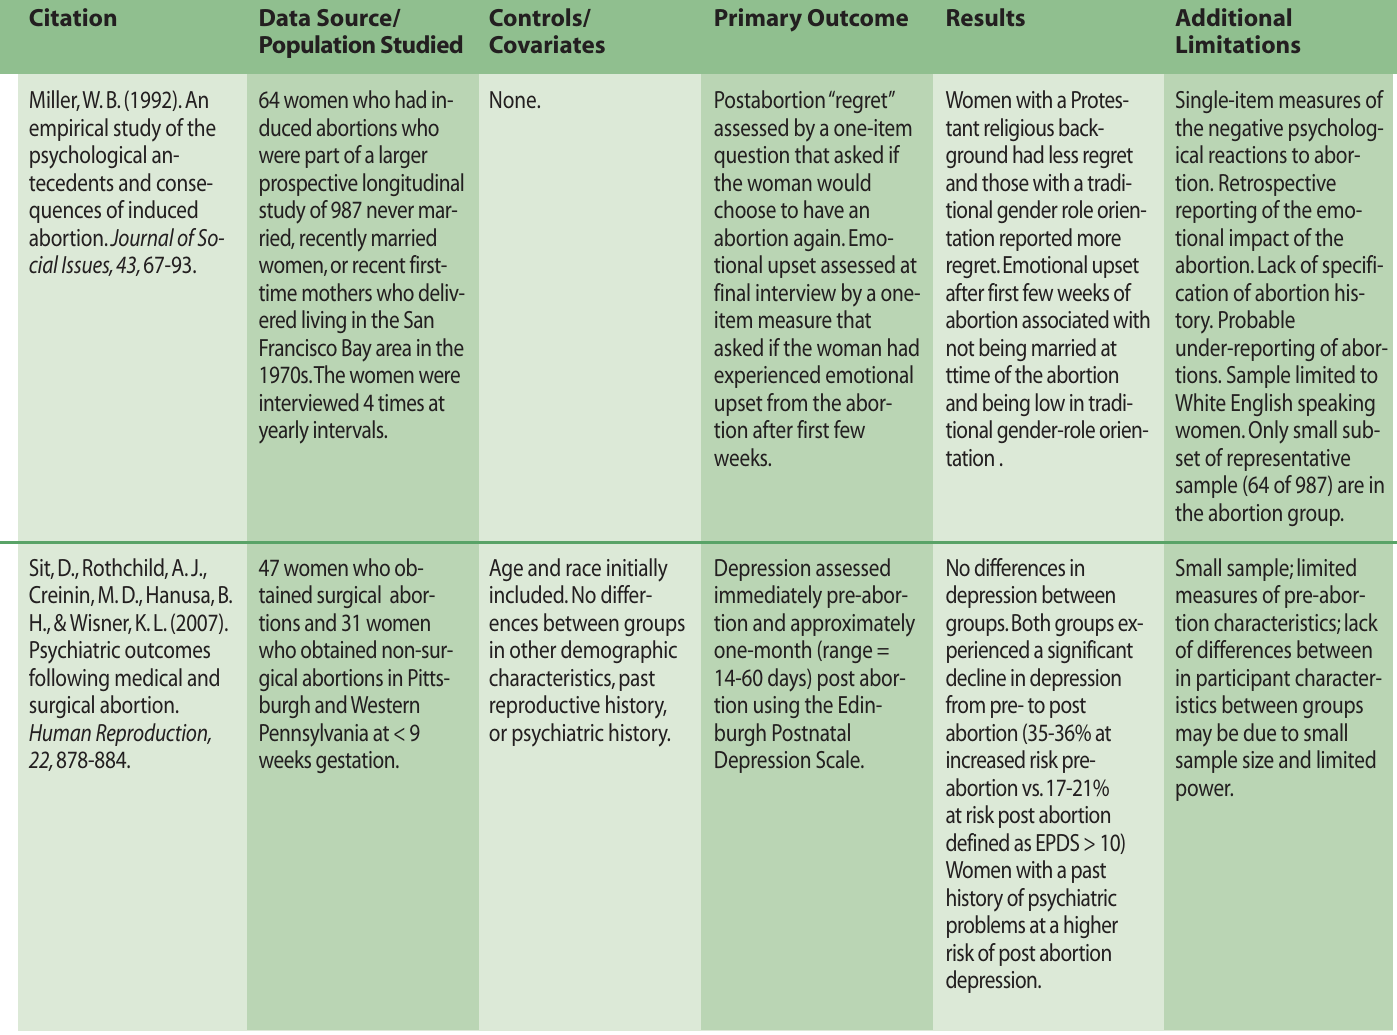
Table 5: U.S.Samples of Abortion Group(s) Only/No Comparison